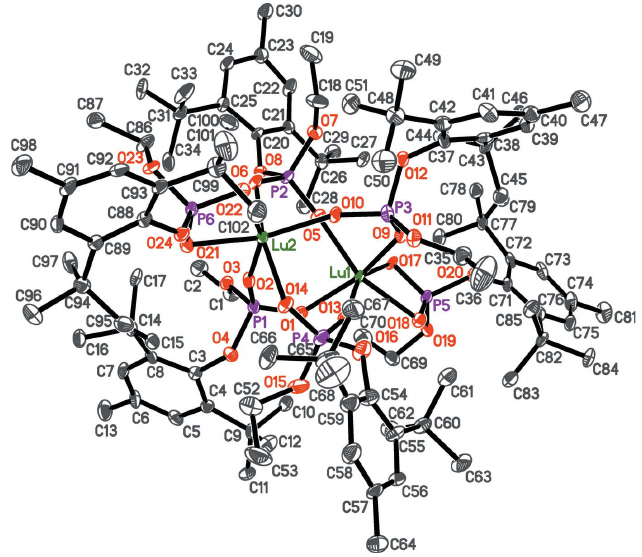
Figure 2 Molecular structure of compound 1 with the atom labelling. Displace- ment ellipsoids are drawn at the 30% probability level. The solvent molecules and hydrogen atoms have been omitted for